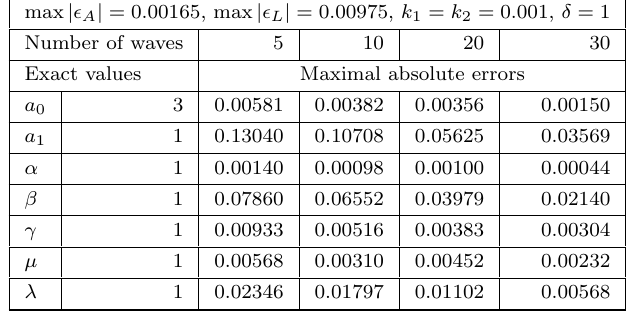
Table 4. Maximal absolute errors (wave characteristics, macro- and